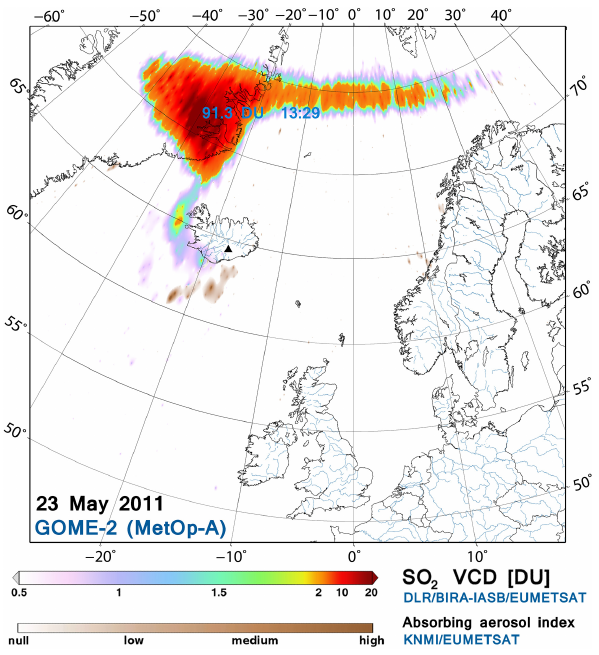
Fig. 21. SO 2 and aerosols (ash) detected by GOME-2A (Grímsvötn eruption, 23 May